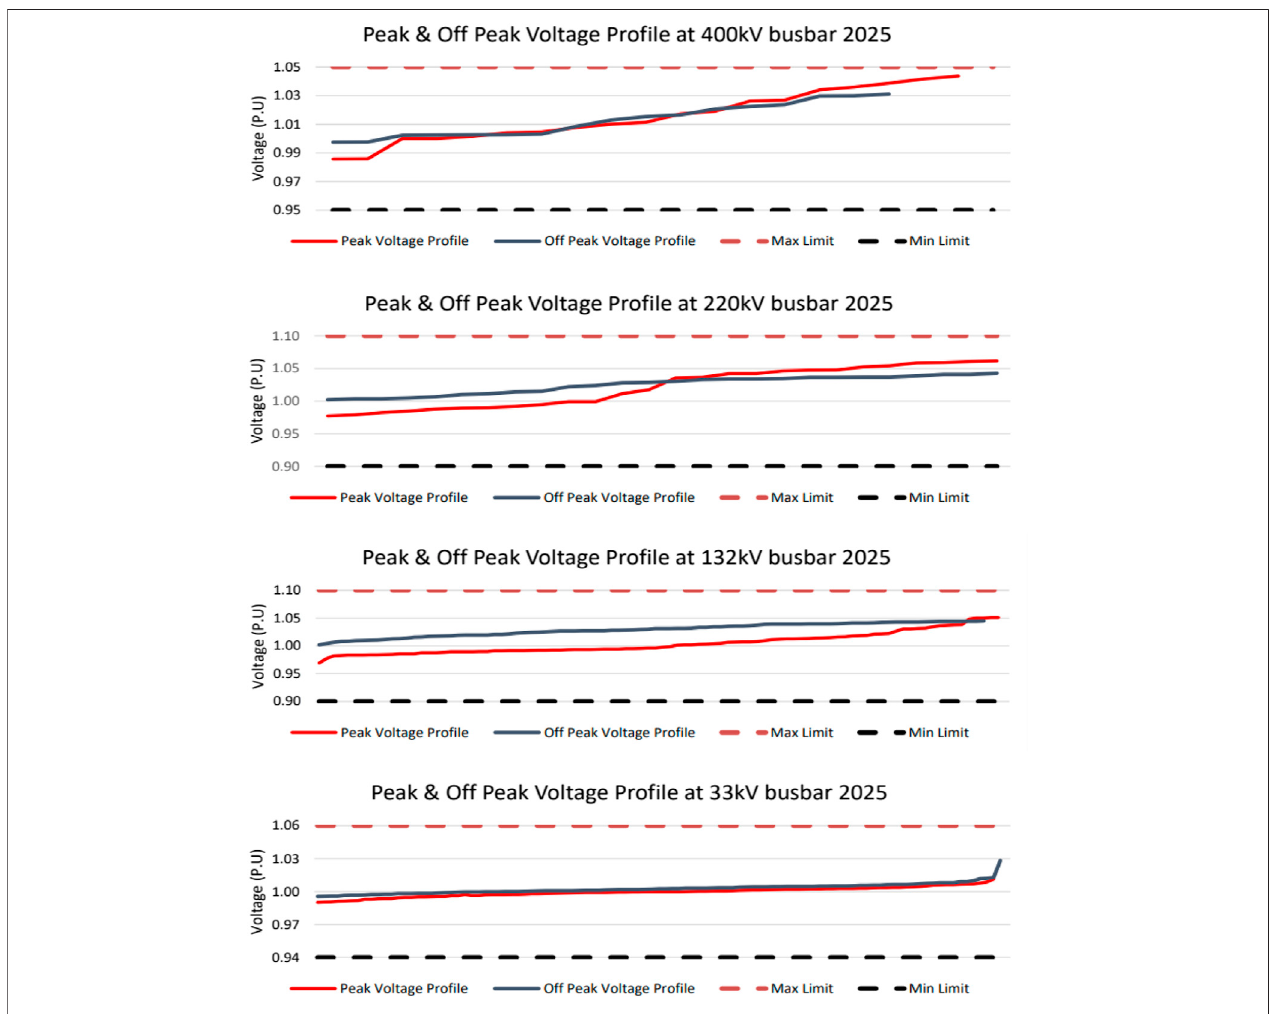
FIGURE 4 | MIS peak and off-peak voltage pro fi les at different power grids in 2025.